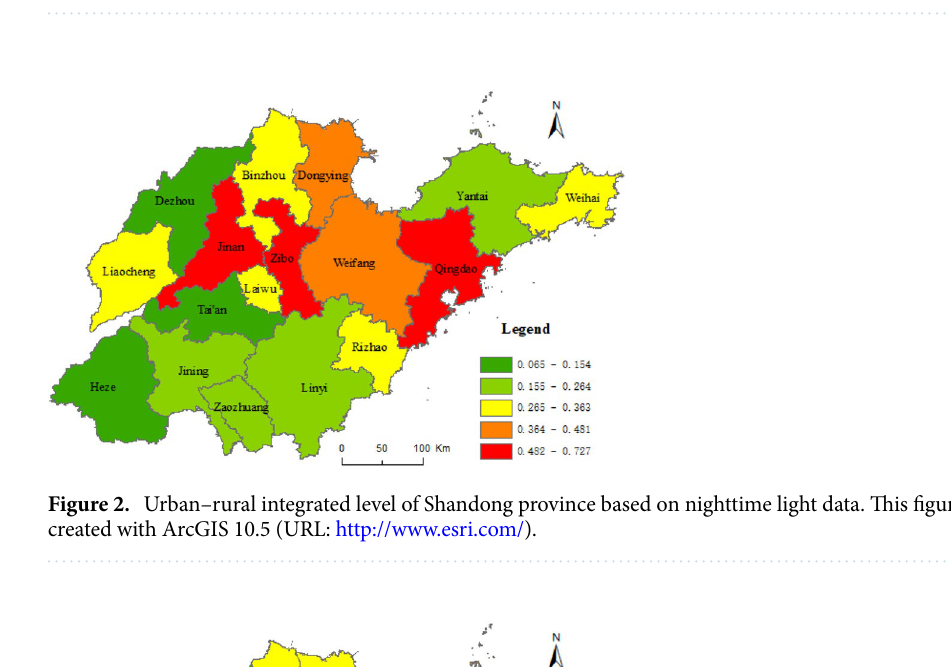
Table 1. Results of urban–rural integrated level of cities in Shandong province.